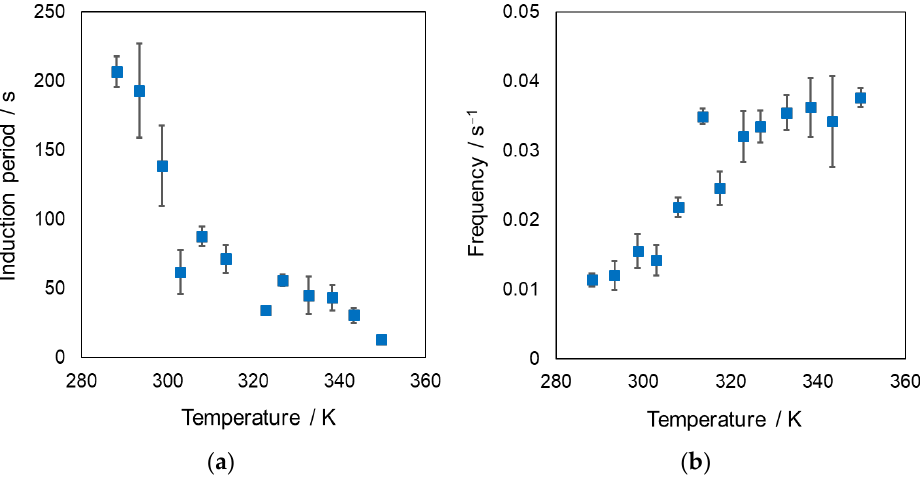
Figure 3. Relation between the temperature of biphasic system and the oscillation characteristics; ( a ) induction period and ( b ) frequency. Only DEHPA was added in these pendant-drop systems, not organic additives. The error bar indicates standard deviation based on triplicate experiments.